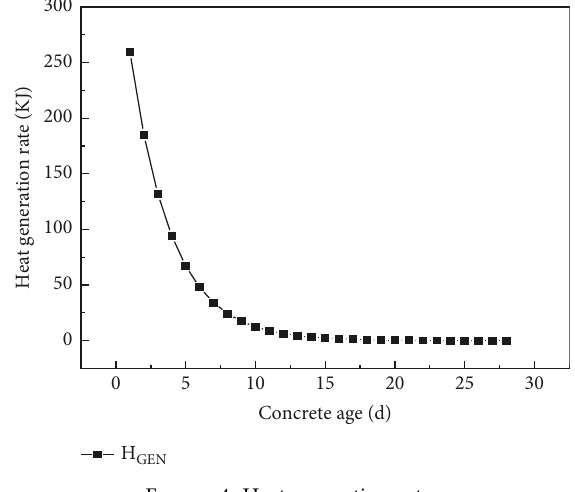
Figure 4: Heat generation